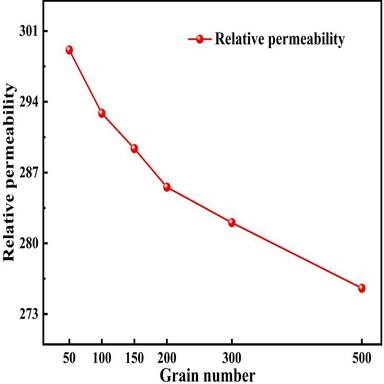
Magnetic flux density distribution of 2D FE model with different phase fractions (ferrite–austenite).